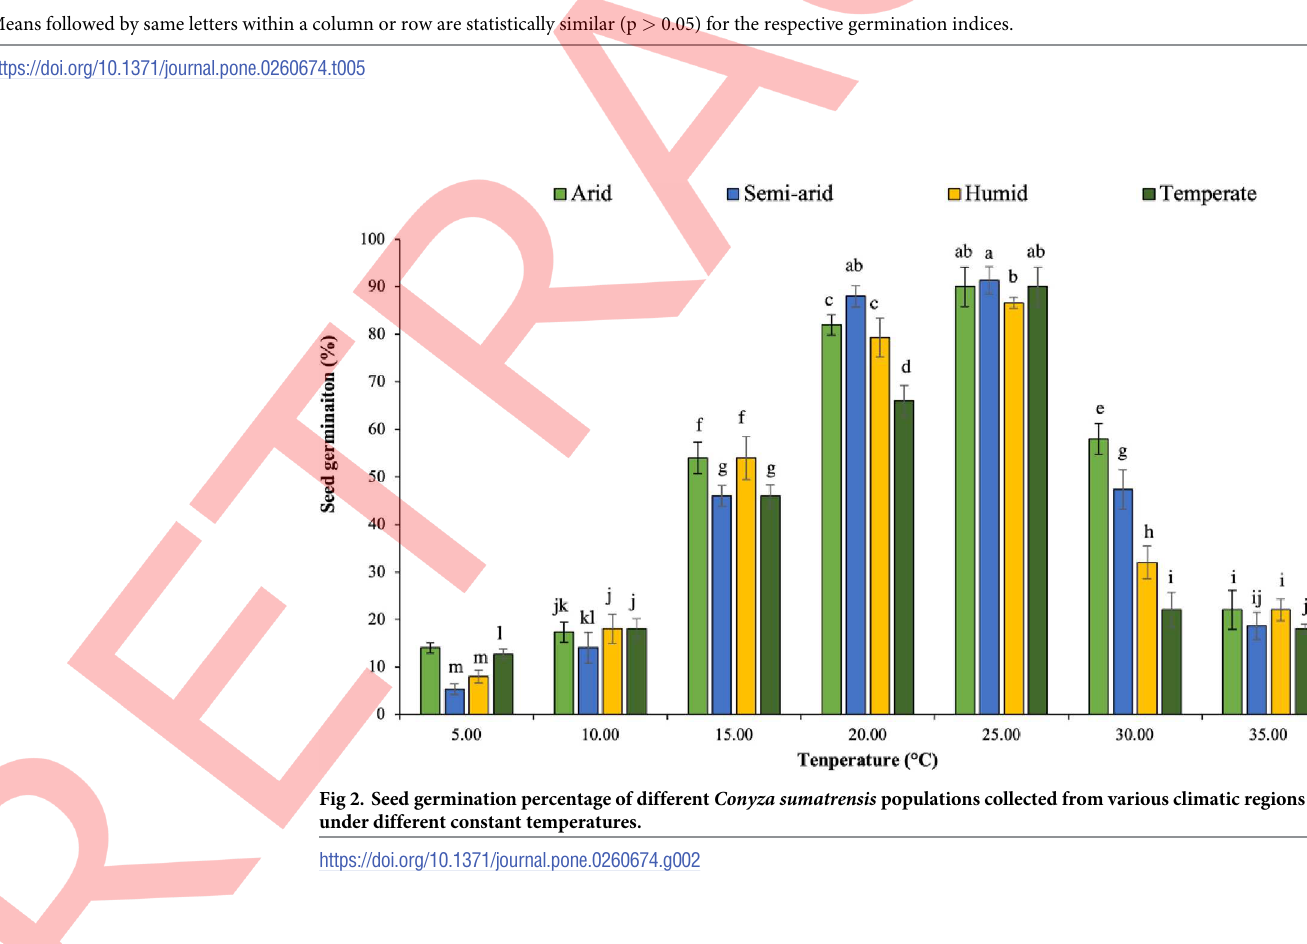
PLOS ONE | https://doi.org/10.1371/journal.pone.0260674 December2,